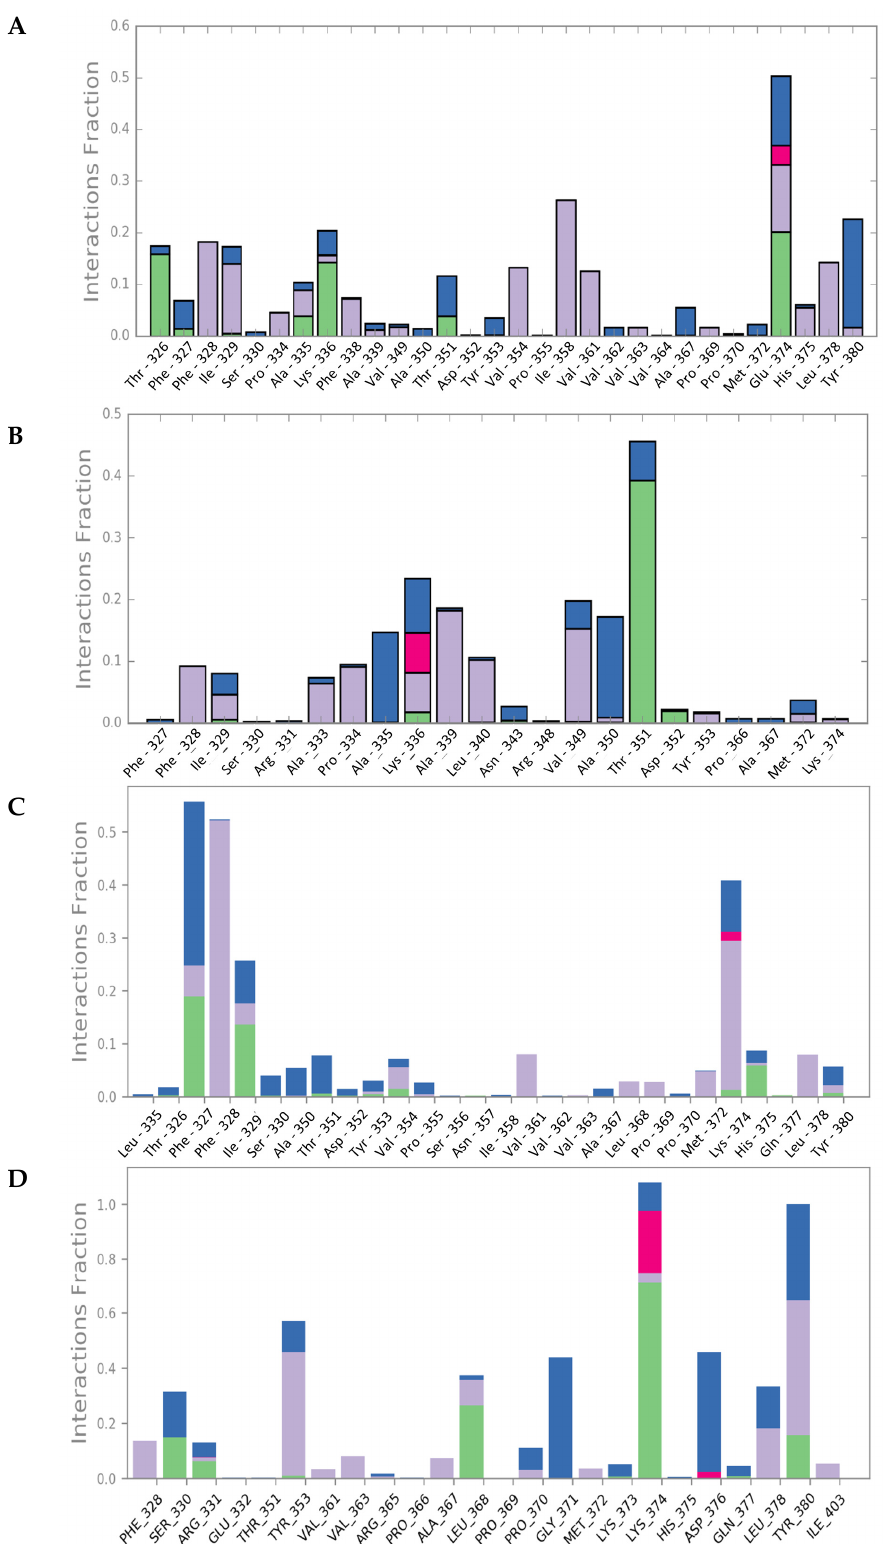
Figure 6. Persistence of the model–ligand interactions found within the constructed Lmj_04_BRCT models and selected compounds during the 50 ns molecular dynamics simulation. ( A ) CPE1-Mult1_lig, ( B ) CPE5-Mult1_lig, ( C ) CPE6-Mult1_lig, ( D ) CPE7-SwissModel_2. Green: hydrogen bonds. Purple: hydrophobic interactions. Red: ionic interactions. Blue: water bridges.